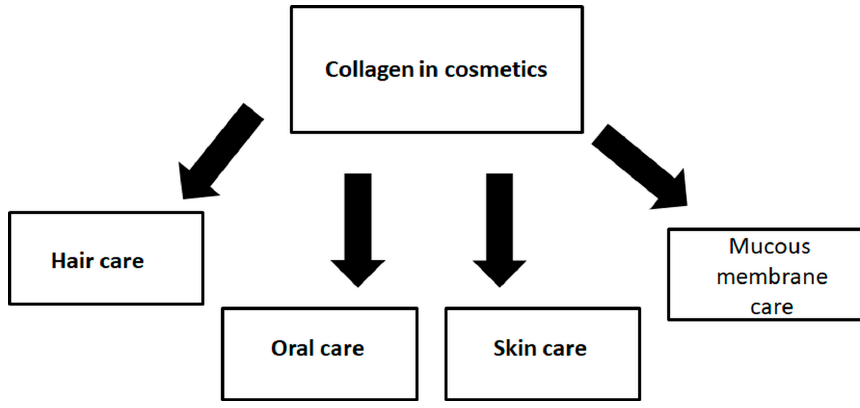
Figure 3. The application of collagen in cosmetics.